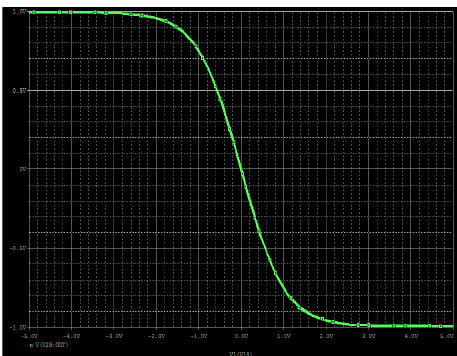
Figure 2. Simulated results of the inverting hyperbolic tangent circuit.